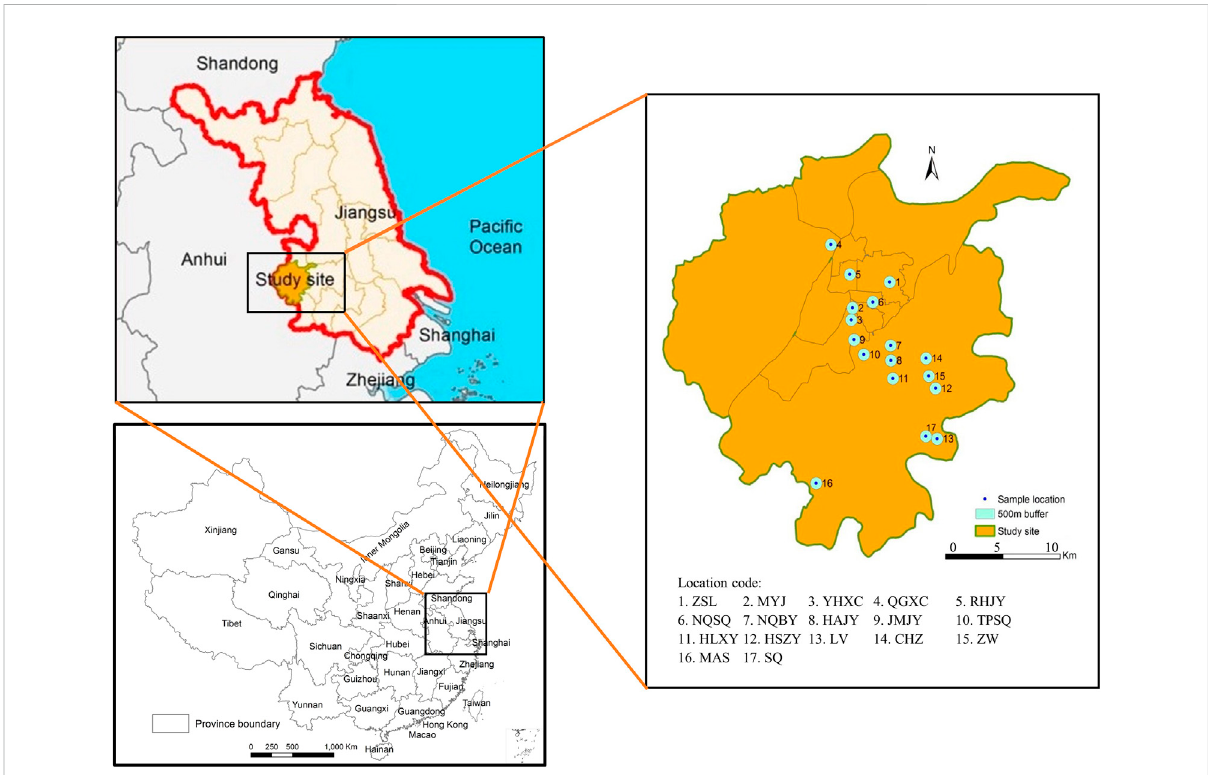
FIGURE 1 Aprovinceandcounty-leveldigitalmapwasobtainedfromChinaResourceandEnvironmentScienceandDataCenter(https://www.resdc.cn/), the detailed location of sample sites were mapped and showed using ArcGIS 10.7 (Environmental Systems Research Institute Inc., Redlands, CA, USA).